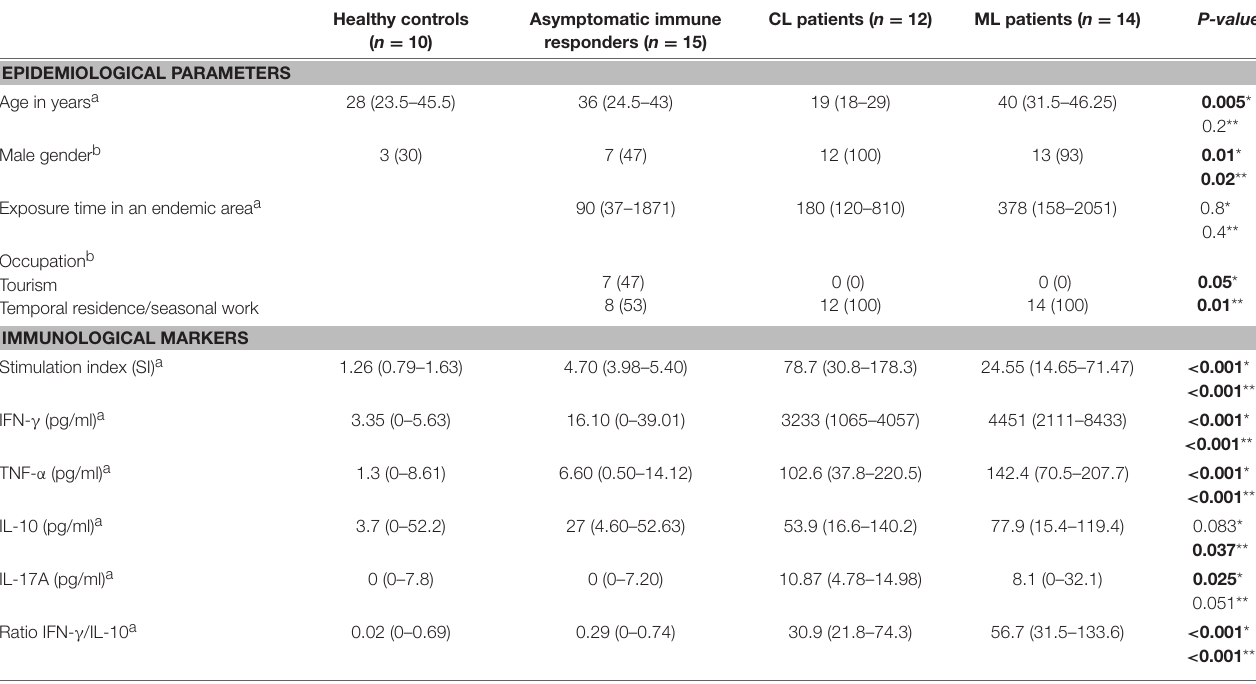
TABLE 1 | Epidemiological parameters and immunological markers in cutaneous and mucosal leishmaniasis patients, asymptomatic immune responders and healthy subjects.